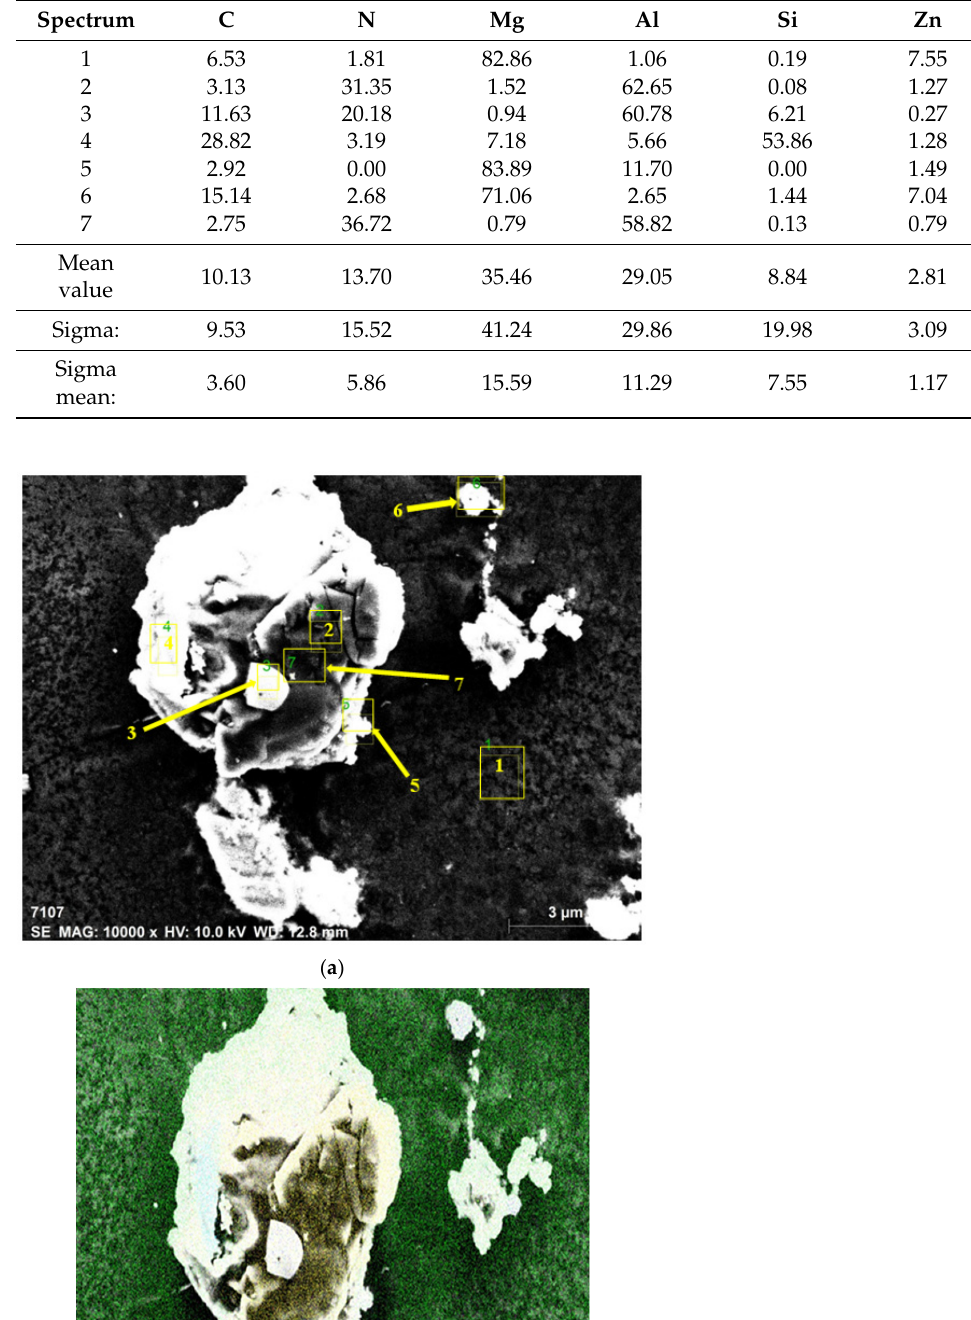
Table 4. The regions’ spectral analysis findings in Figure 4a for ZK60 + 15% SiC + 0.5 AIN.